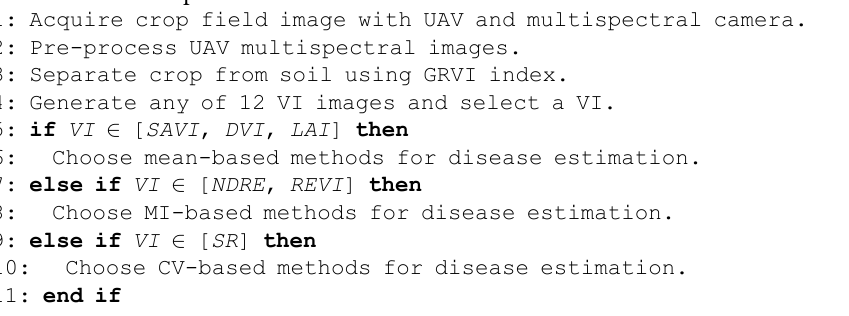
Procedure 1 Cooperative scheme for LLS disease estimation